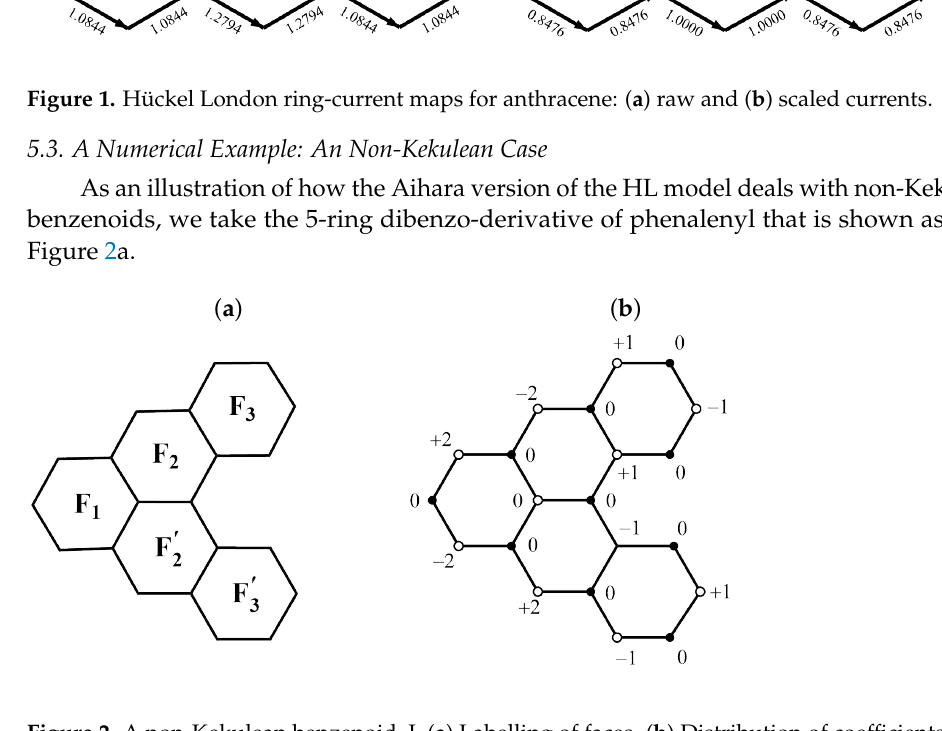
Figure 2. A non-Kekulean benzenoid, I. ( a ) Labelling of faces. ( b ) Distribution of coefficients in the unique non-bonding Hückel molecular orbital. For the normalised orbital, multiply all entries by √ 1/